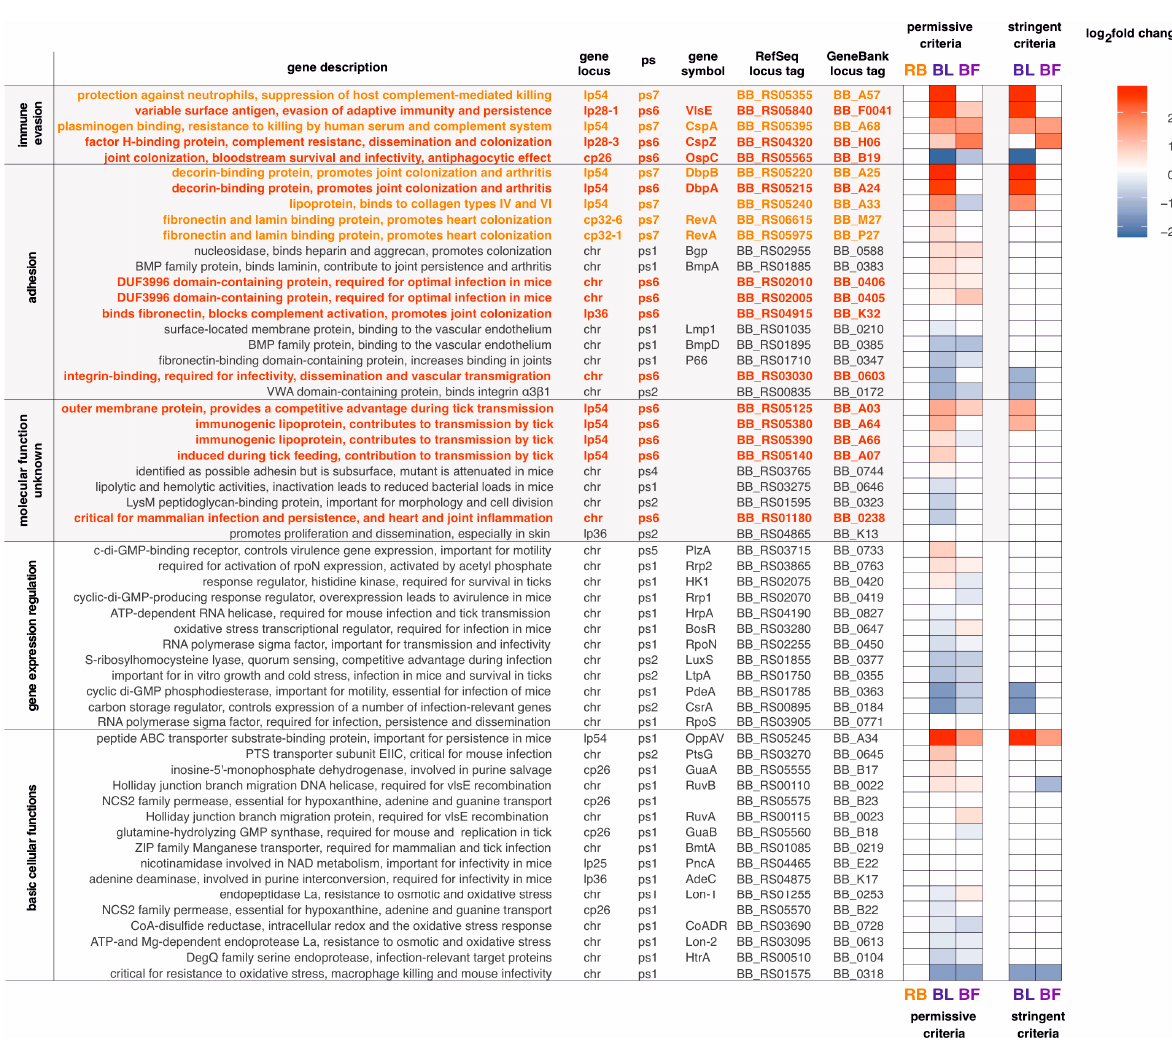
Figure 7. B. burgdorferi virulence genes are showing a morphotype-dependent transcription profile. We sorted out B. burgdorferi virulence genes known to be involved in Lyme disease pathogenesis